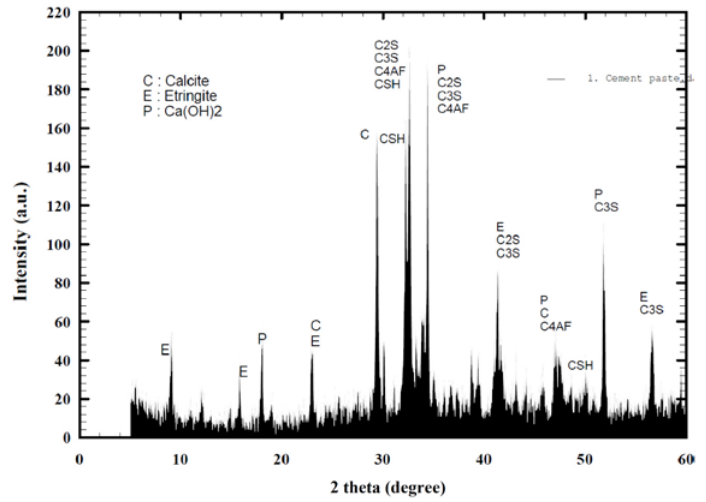
Figure 8. XRD results for cement paste.